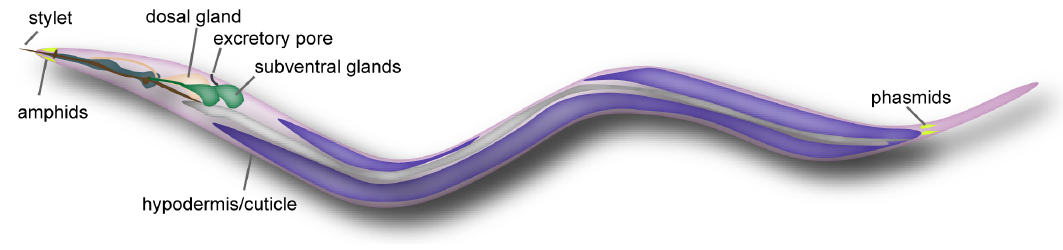
Figure 1. Illustration of natural openings and secretory organs of a typical plant parasitic nematode.